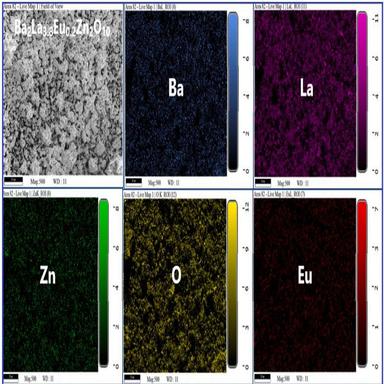
Energy Dispersive Maps of all elements present in optimized doped nanophosphor Ba2La3.8Eu0.2Zn2O10 in a field of view of the spectrum.